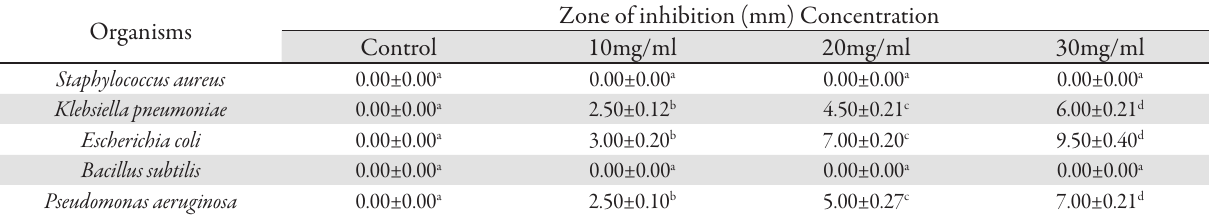
Key: Each value is a mean of three determinations ± standard deviation. Different superscripts across the table are significantly different ( p